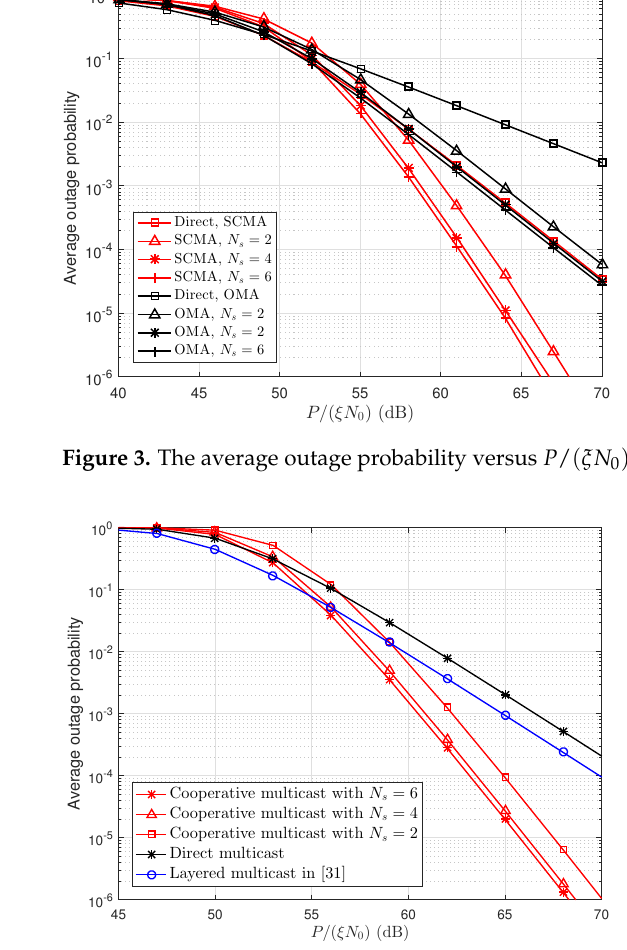
Figure 4. Average outage probability of proposed scheme and scheme in